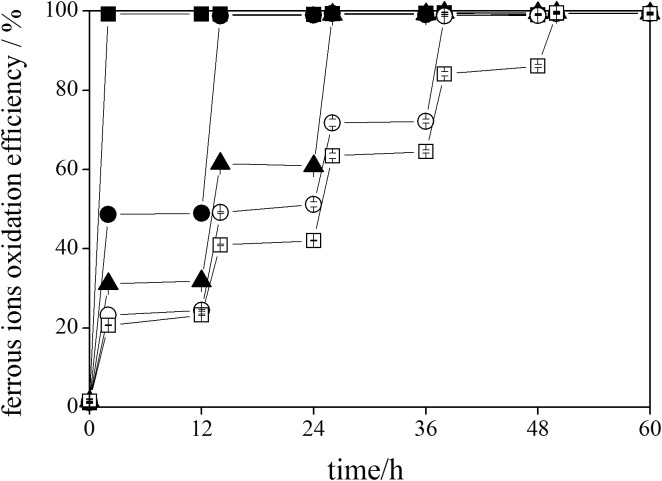
Variations in ferrous oxidation efficiency during ferrous ions chemical oxidation with H2O2 adding FeSO4·7H2O solution at different rates.150 mL of FeSO4·7H2O solution with addition of ■: 1.80 mL of H2O2 at 2 h (treatment 1); ●: 0.90 mL of H2O2 at 2 and 14 h (treatment 2); ▲: 0.60 mL of H2O2 at 2, 14, and 26 h (treatment 3); ○: 0.45 mL of H2O2 at 2, 14, 26, and 38 h (treatment 4); □: 0.36 mL of H2O2 at 2, 14, 26, 38, and 50 h (treatment 5).